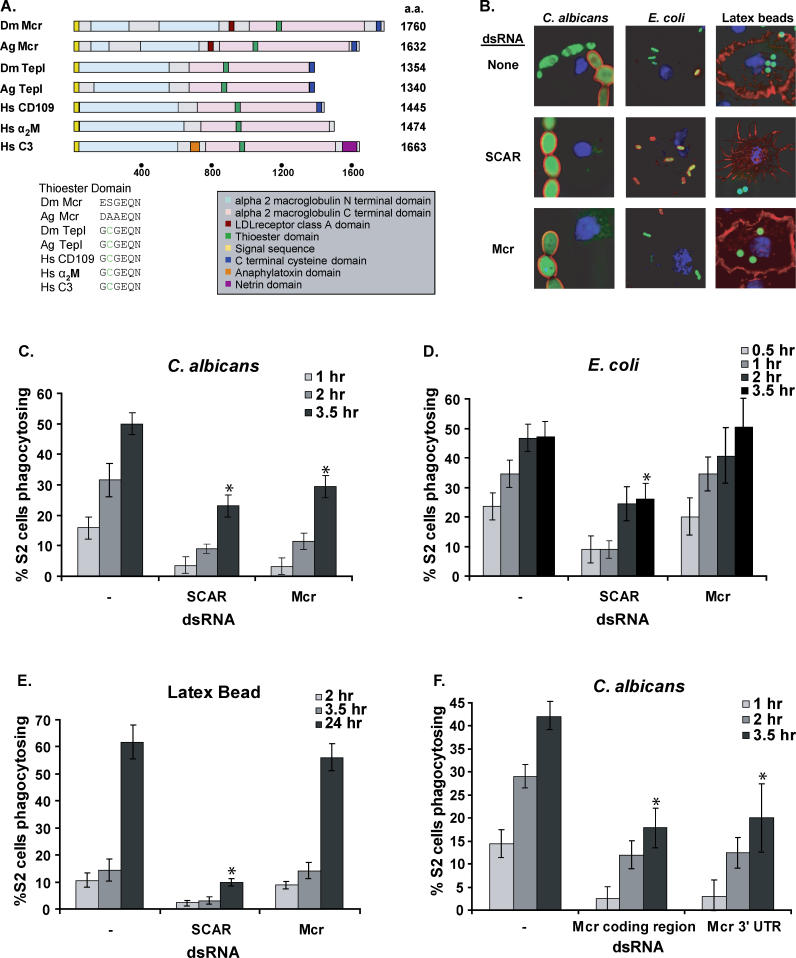
Mcr-Dependent Phagocytosis of C. albicans
(A) Schematic representation of α2M-related proteins. Drosophila Mcr is compared with a close homolog in A. gambiae (Ag Mcr [Tep13]), TepI from both Drosophila and Anopheles and the human homologs CD109, α2M, and C3. Various conserved domains are colored as indicated in the gray box. Numbers correspond to amino acid position. The sequences of the conserved thioester domains are given below the schematic. Dm, Drosophila melanogaster; Ag, Anopheles gambiae; Hs, Homo sapiens.(B) RNAi against SCAR reduces phagocytosis of C. albicans, E. coli, and latex beads (row 2). RNAi against Mcr significantly decreased phagocytosis of only C. albicans (row 3). Cells were stained as in Figure 4C–4E. Column 1, GFP expressing C. albicans—green, S2 cell DNA—blue, non-phagocytosed C. albicans—red; column 2, GFP-expressing E. coli—green, S2 cell DNA—blue, non-phagocytosed E. coli—red; column 3, latex beads—green, S2 cell DNA—blue, S2 cell actin cytoskeleton—red.(C) dsRNA against both SCAR and Mcr decreases phagocytosis of C. albicans. S2 cells were treated with dsRNA against SCAR and Mcr as described in Materials and Methods and then co-incubated with C. albicans for the indicated times. The percentage of S2 cells phagocytosing one or more C. albicans was quantified and plotted. The 3.5-h timepoints were analyzed using a t-test assuming unequal variance. Those values that differ significantly from untreated cells (p < 0.01) are indicated by asterisks.(D) Mcr dsRNA does not reduce phagocytosis of E. coli. S2 cells were treated with dsRNA against SCAR and Mcr and then co-incubated with E. coli for the indicated times. The percentage of S2 cells phagocytosing one or more E. coli was quantified and plotted. The 3.5-h timepoints were analyzed using a t-test assuming unequal variance. Those values that differ significantly from untreated cells (p < 0.01) are indicated by asterisks.(E) Mcr dsRNA does not reduce phagocytosis of latex beads. S2 cells were treated with dsRNA against SCAR and Mcr and then co-incubated with green fluorescent latex beads for the indicated times. The percentage of S2 cells phagocytosing one or more latex beads was quantified and plotted. The 3.5-h timepoints were analyzed using a t-test assuming unequal variance. Those values that differ significantly from untreated cells (p < 0.01) are indicated by asterisks.(F) An additional dsRNA against the 3′ UTR of Mcr was generated and tested for disruption of C. albicans phagocytosis. S2 cells were treated with RNAi directed against both the coding region and the 3′ UTR of Mcr and then co-incubated with C. albicans for the indicated times. The percentage of S2 cells phagocytosing one or more C. albicans was quantified and plotted. The 3.5-h timepoints were analyzed using a t-test assuming unequal variance. Those values that differ significantly from untreated cells (p < 0.01) are indicated by asterisks.